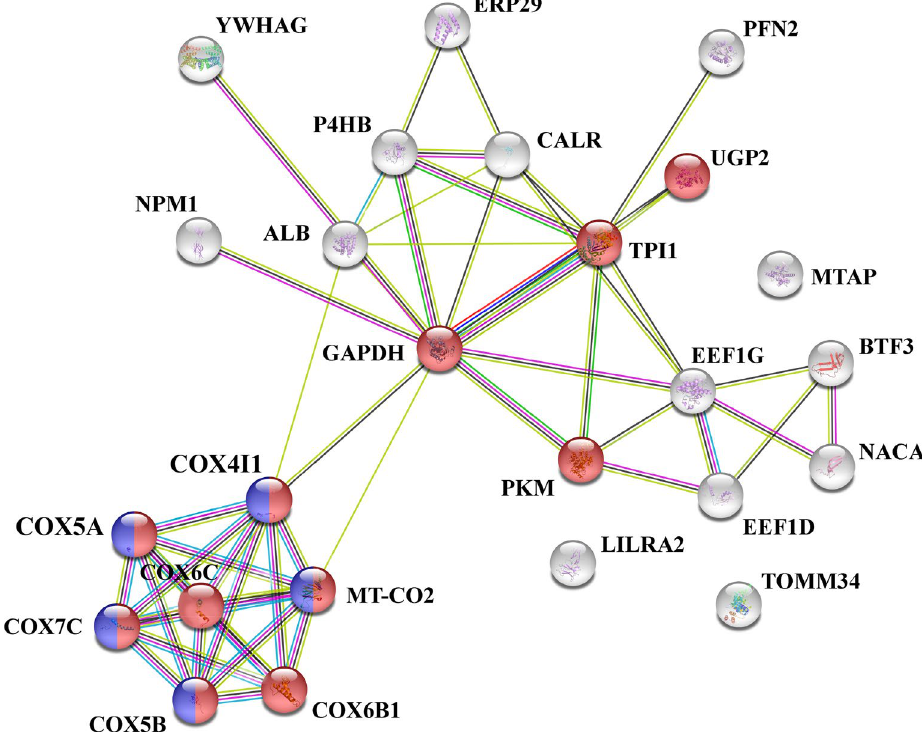
Figure 2. STRING analysis of 15 phosphoproteins altered in response to antibody dependent enhancement of DENV 2 infection. A total of 15 phosphoproteins identified as differentially expressed in response to antibody dependent enhancement of DENV 2 infection were submitted to the STRING database for analysis. Proteins identified as part of the generation of precursor metabolites and energy are shown in red, while proteins identified as part of mitochondria electron transport, cytochrome c to oxygen are shown in blue. Proteins involved in both processes are shown as dual